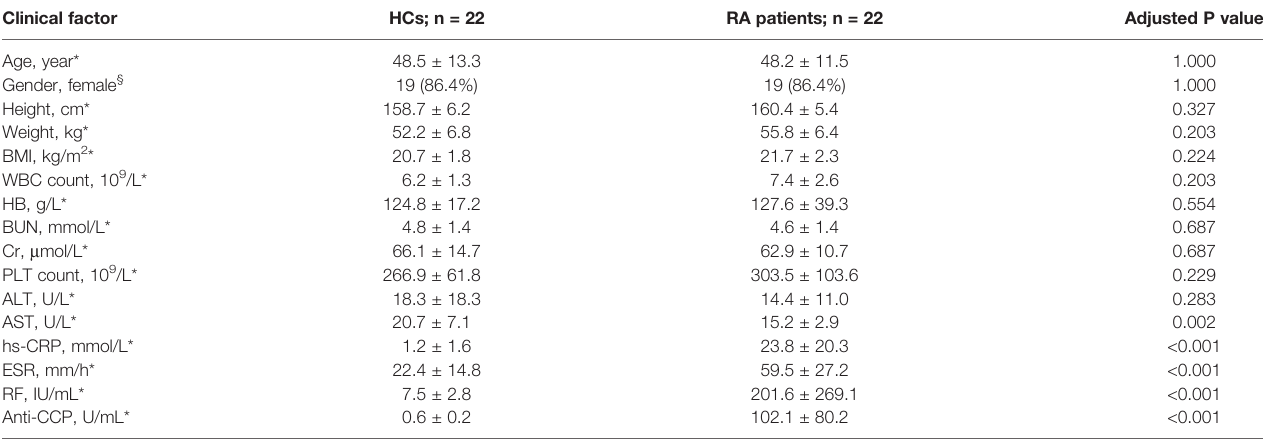
TABLE 1 | Baseline characteristics of healthy controls (HC; n = 22) and rheumatoid arthritis (RA) patients (n = 22). Clinical factor HCs; n =